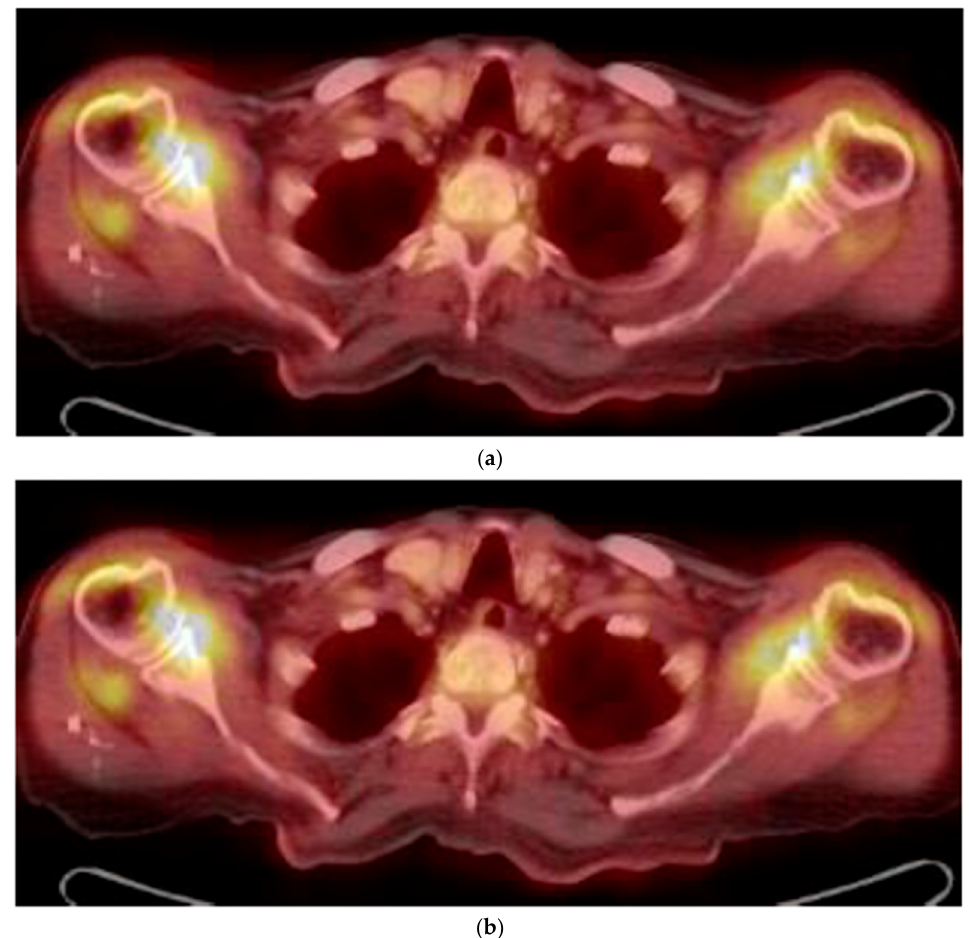
Figure 2. ( a ) FDG uptake in both the shoulder (18-FDG PET/CT fused axial slice); ( b ) FDG uptake in hips and subtrochanteric bursae.